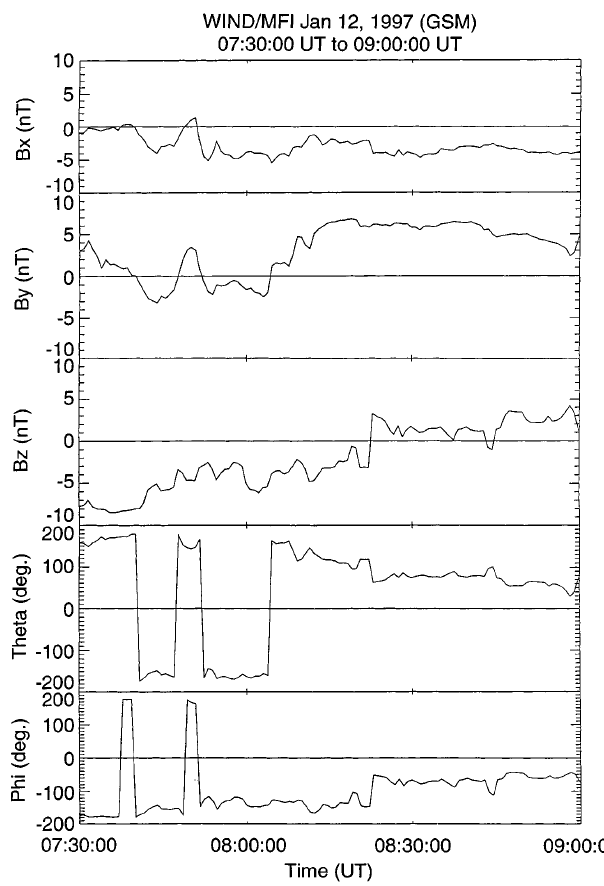
Fig. 3. IMF observations by the WIND satellite on 12 January 1997, between 07:30 and 09:00 UT. The estimated satellite-to-ionospheric cusp propagation delay is about 25 min. The panels show (from top to bottom ) the B , B and B IMF components (in the GSM frame and x y z in nT), the clock angle h , defined by Eq. (1), and the elevation angle / , defined by Eq. (2) (both in degrees)